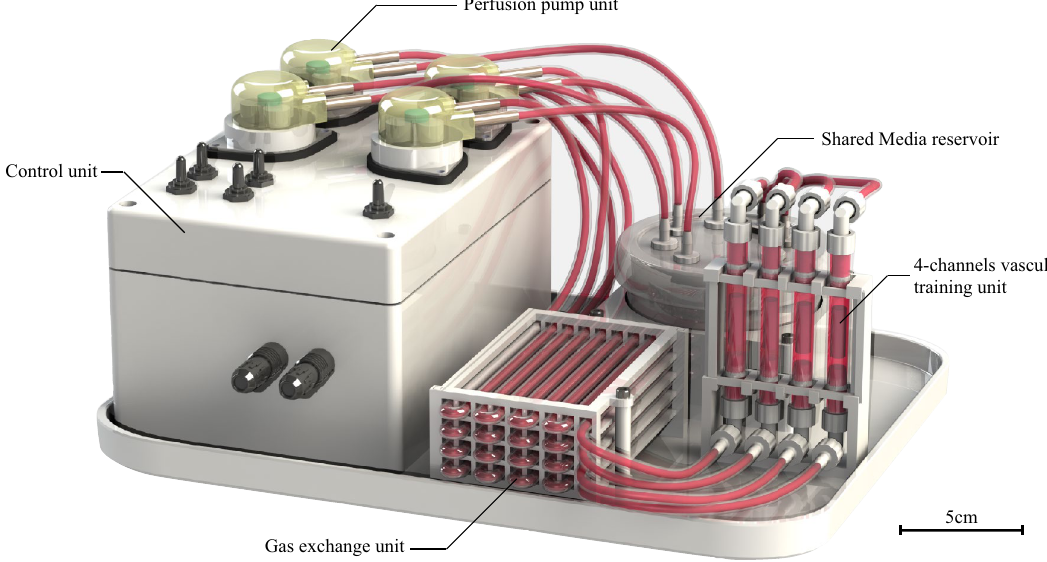
Figure 14. The overview of the 4-channel bioreactor for maturation of proto-tissues into the trained vascular tissue by individual training flow programs. Scale bar = 5 cm. A part of the image was created by the rendering function of SOLIDWORKS 2018.